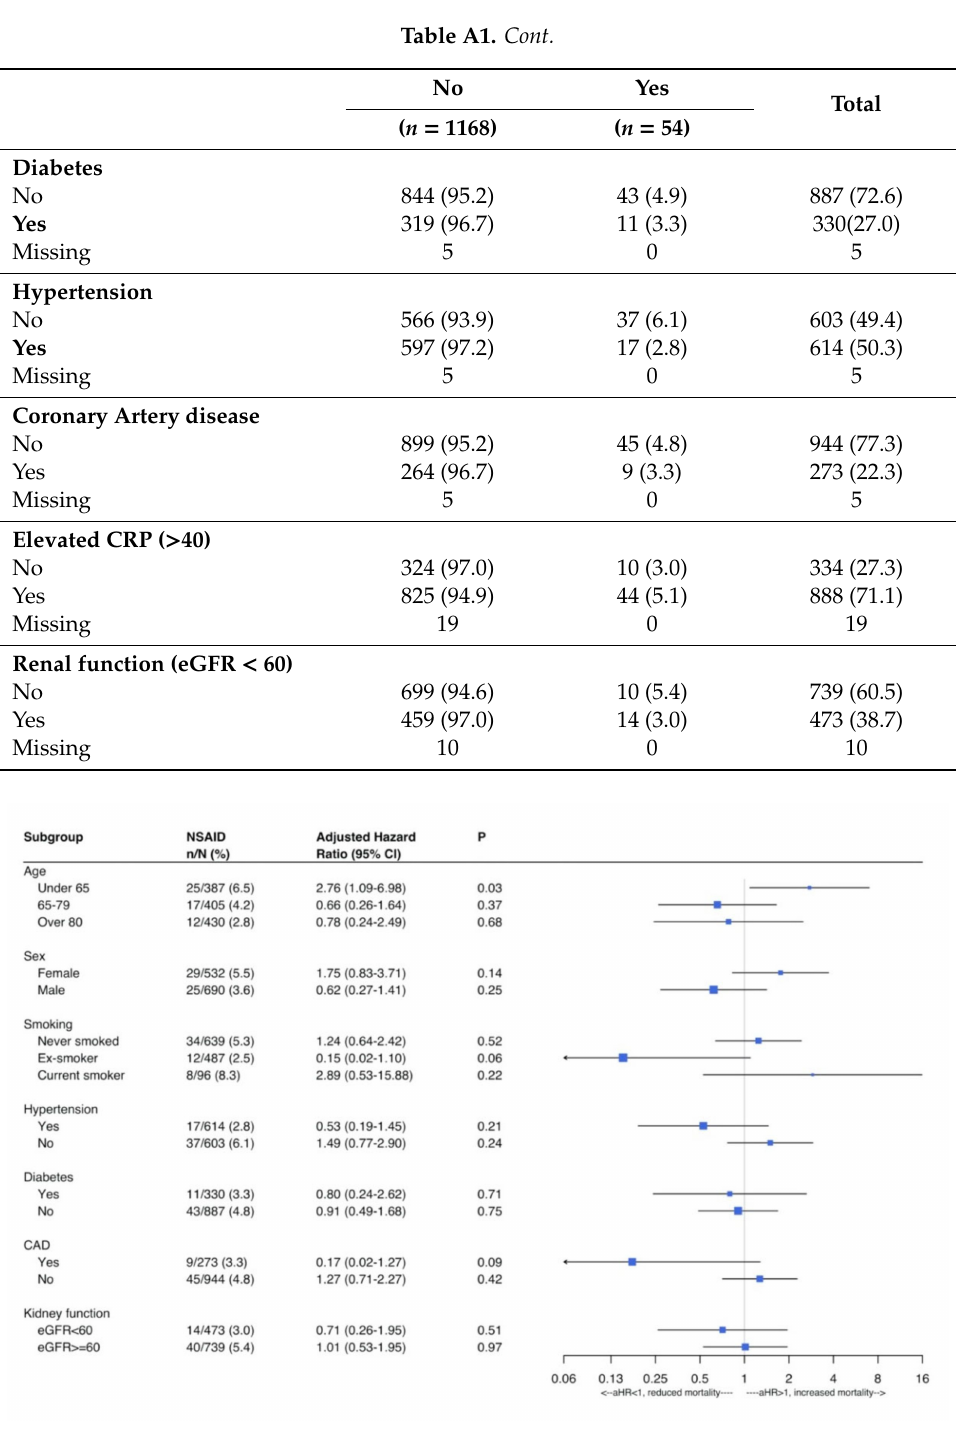
Figure A1. Subgroups: time to mortality, adjusted hazard ratio are presented from the multivariable Cox PH model. Note: multivariable analyses adjusted for age group, sex, smoking status, hypertension, diabetes, CAD, kidney function and elevated CRP